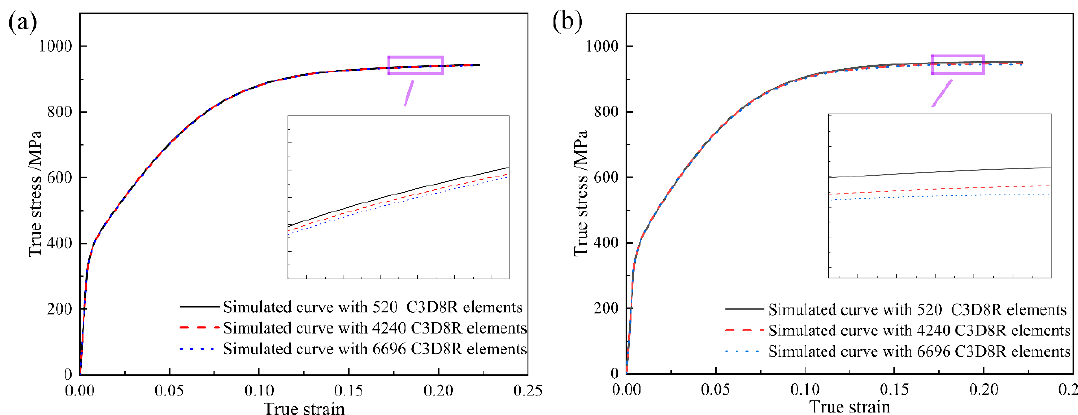
Figure A1. Simulated stress-strain curves in the case of 520 C3D8R elements, 4240 C3D8R elements and 6696 C3D8R elements during uniaxial compression with various coefficient of friction: ( a ) Friction coefficient of 0.05; ( b ) Friction coefficient of 0.35.